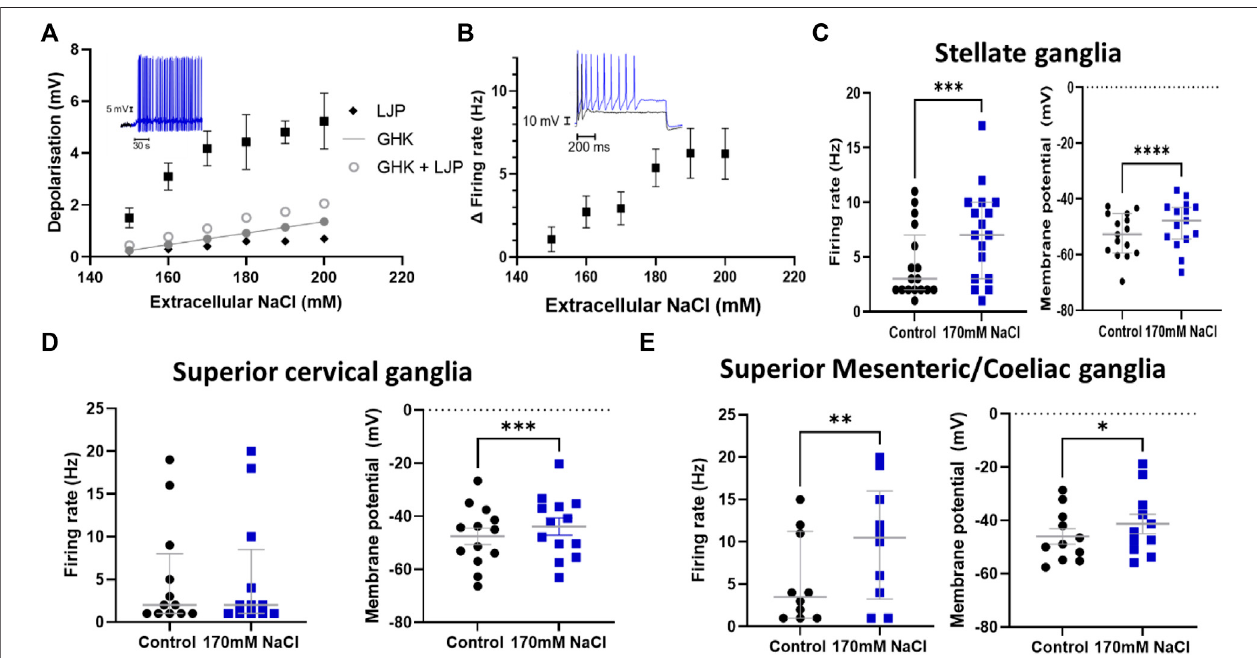
FIGURE1| SympatheticstellateganglianeuronsareexcitedbyacuteelevatedNaCl. (A) Theeffectof[NaCl] o onstellateganglianeuronmembranepotential(Black) is dose dependent between 150 – 200 mM and is greater than that predicted by the calculated change in liquid junction potential (Black diamond), Goldman-Hodgkin- Katz equation (Closed grey circles), or thecombinedGoldman-Hodgkin-Katz equation and calculated changein liquid junctionalpotential (Opengrey circles).Insetdata trace shows membrane depolarization and resulting spontaneous fi ring following 170 mM [NaCl] o (Blue) following an initial period in 140 mM NaCl (Black) ( n = 12 – 22; Welch ’ s ANOVA test, p < 0.0001). (B) The increase in fi ring rate following an increase in extracellular Na + concentration is shown as Mean ± SEM (n = 8 – 18; Welch ’ s ANOVA, p = 0.01). The inset trace shows the evoked response of a stellate ganglia neuron to 150 pA current injection before and after treatment with 170 mM NaCl. The black trace represents a recording at 140 mM NaCl, the blue trace is following 170 mM NaCl. (C) The addition of 170 mM NaCl signi fi cantly depolarized culturedstellateganglianeuronsandcausedanincreaseinmaximuminduced fi ring.170mMNaClincreasedneuron fi ring(3Hz – 7 Hz;n=17;Wilcoxontest; p =0.0009) (Left)andinducedstellateganglianeuronmembranedepolarization(4.07±0.75mV;n=15;Paired t -test; p < 0.0001)(Right)and. (D) AnincreaseinextracellularNaClto 170 mM also signi fi cantly depolarized cultured superior cervical ganglion neurons (3.68 ± 0.78 mV; n = 13; Paired t -test; p = 0.0005) (Right), but did not signi fi cantly increase their stimulated maximum fi ring rate (19 Hz – 20 Hz; n = 12; Wilcoxon test; p = 0.48) (Left). (E) Increasing extracellular NaCl to 170 mM caused signi fi cantly increased neuronal fi ring rate (3.5 Hz – 10 Hz; n = 10; Wilcoxon test; p = 0.008) (Left) and a signi fi cant depolarization of superior mesenteric/coeliac ganglia resting membrane potential (4.72 ± 1.53 mV; n = 11; Paired t -test; p = 0.01)